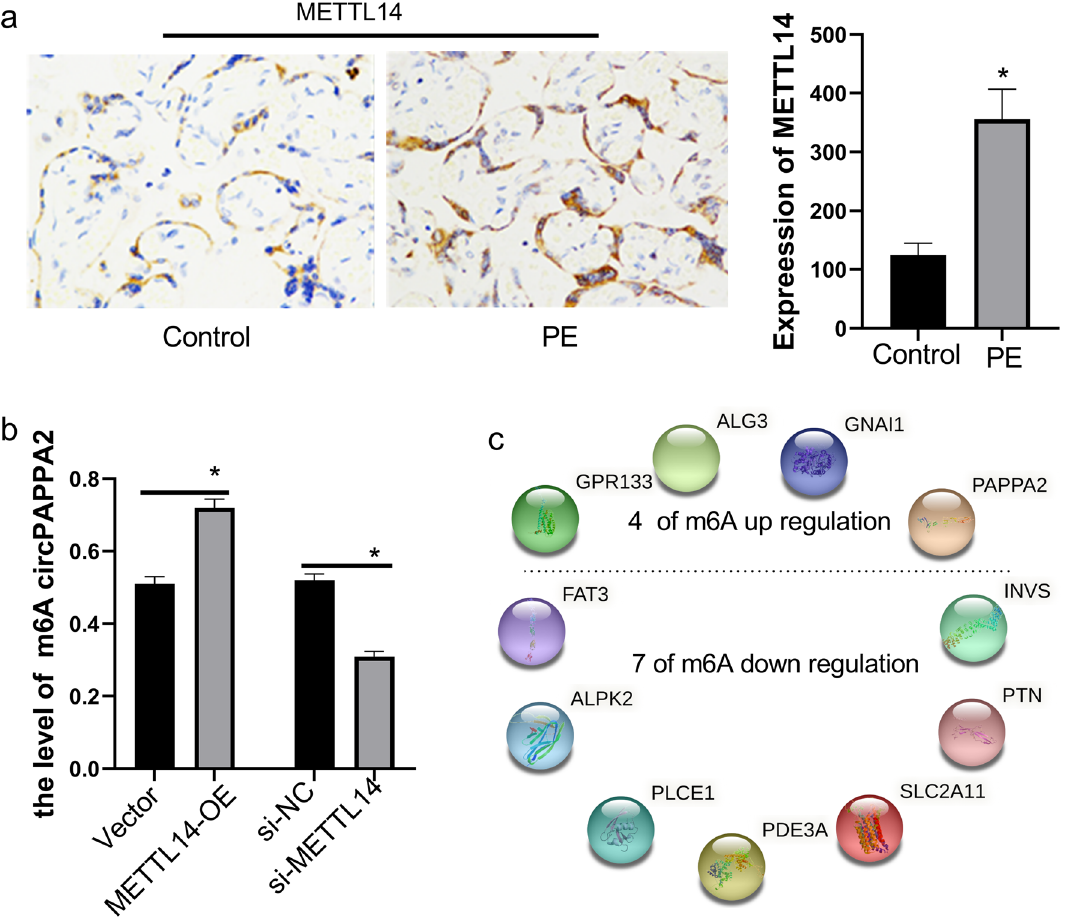
Figure 7. METTL14 showed increased expression in PE placentas in the immunohistochemistry assay (* P < 0.05) ( a ). When METTL14 was overexpressed in TEV1 cells, the circPAPPA2 m6A methylation level increased. With si-METTL14, the level of circPAPPA2 m6A methylation decreased (* P < 0.05) ( b ). There were 4 upregulated and 7 downregulated m6A-methylated circRNAs with the potential to encode proteins according to m6A RNA sequencing data analysis using cORF software and IRESfinder software ( c ). circRNAs were selected based on an ORF length > 150, the presence of an IRES, and the presence of start codon regions with different methylation sites (GPR133, ALG3, GNAI1, PAPPA2, PLCE1, INVS, SLC2A11, PDE3A, FAT3, PTN, and ALPK2 represent circGPR133, circALG3, circGNAI1, circPAPPA2, circPLCE1, circINVS, circSLC2A11, circPDE3A, circFAT3, circPTN, and circALPK2,